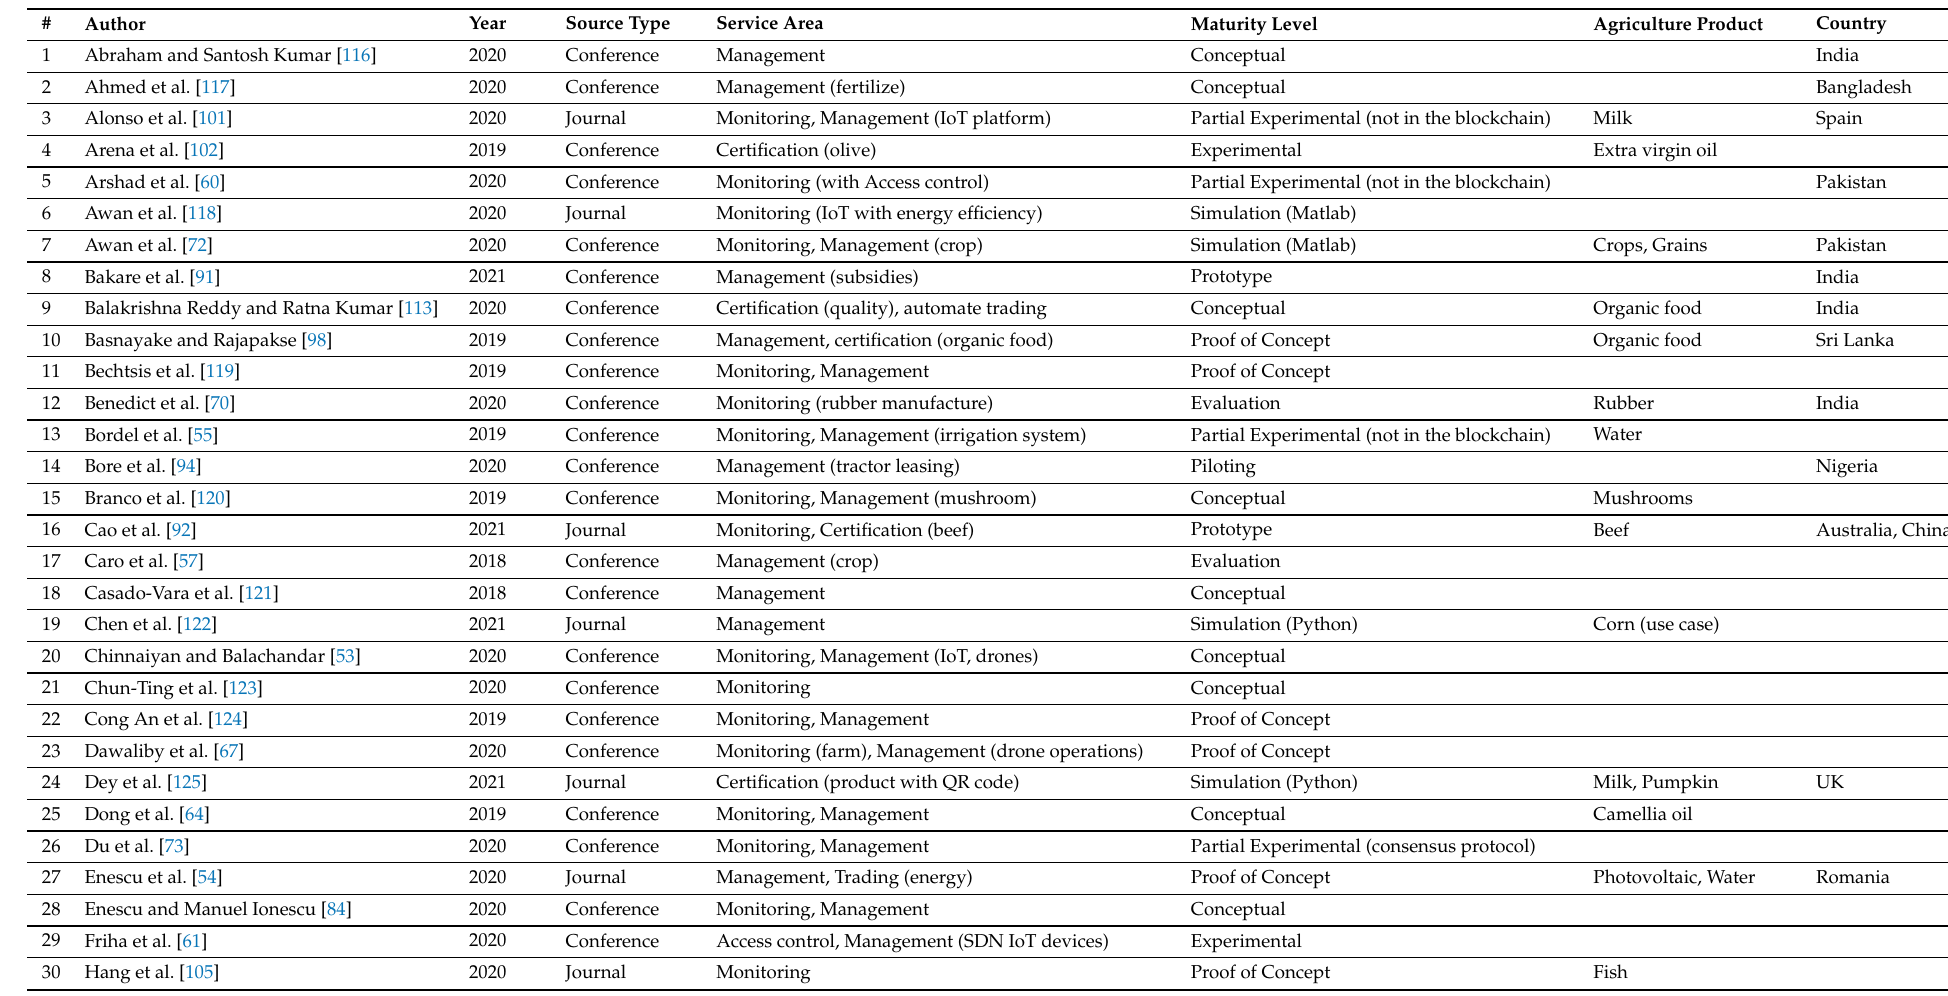
Table 1. Research papers included in the scoping review, their characteristics, the agriculture products on which they focus, and the country of